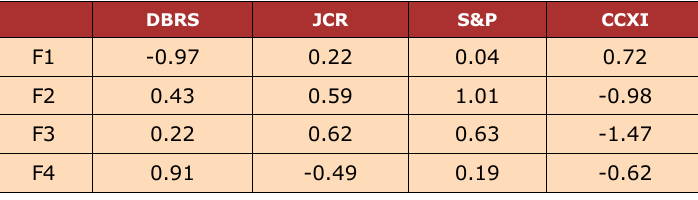
Table 12. The Summary of Assessment